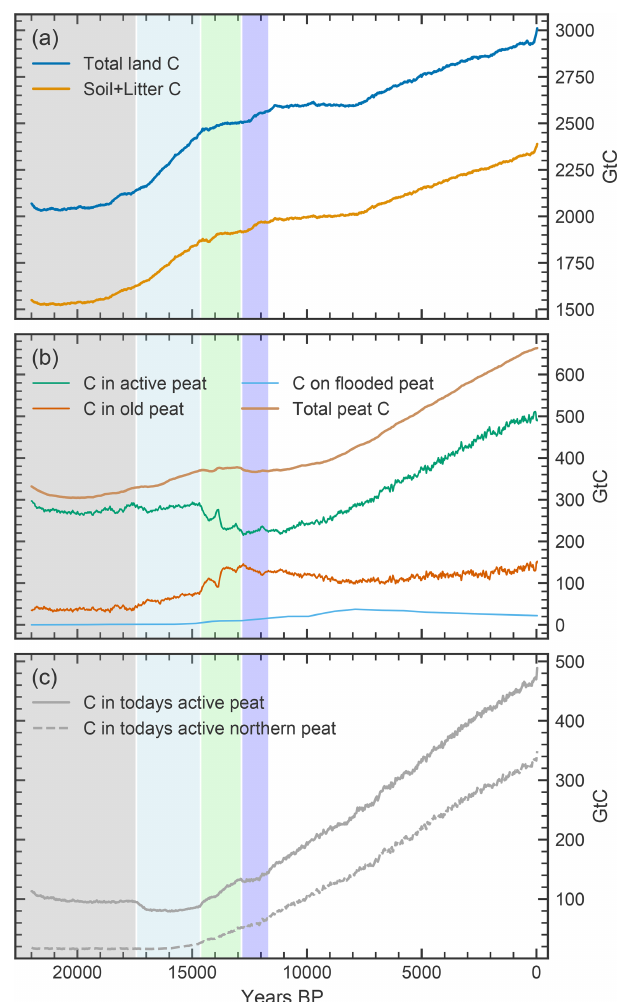
Figure 8. Carbon on global land (soil + litter + vegetation) (a) ; on active peatland areas, old peatland areas, and on flooded continental shelves (b) ; and in today’s active peatlands (c) . The brown line in panel (b) represents global carbon that originated from peatlands, even if it is not part of an active peatland anymore. The background colors indicate different time periods, as in Fig.